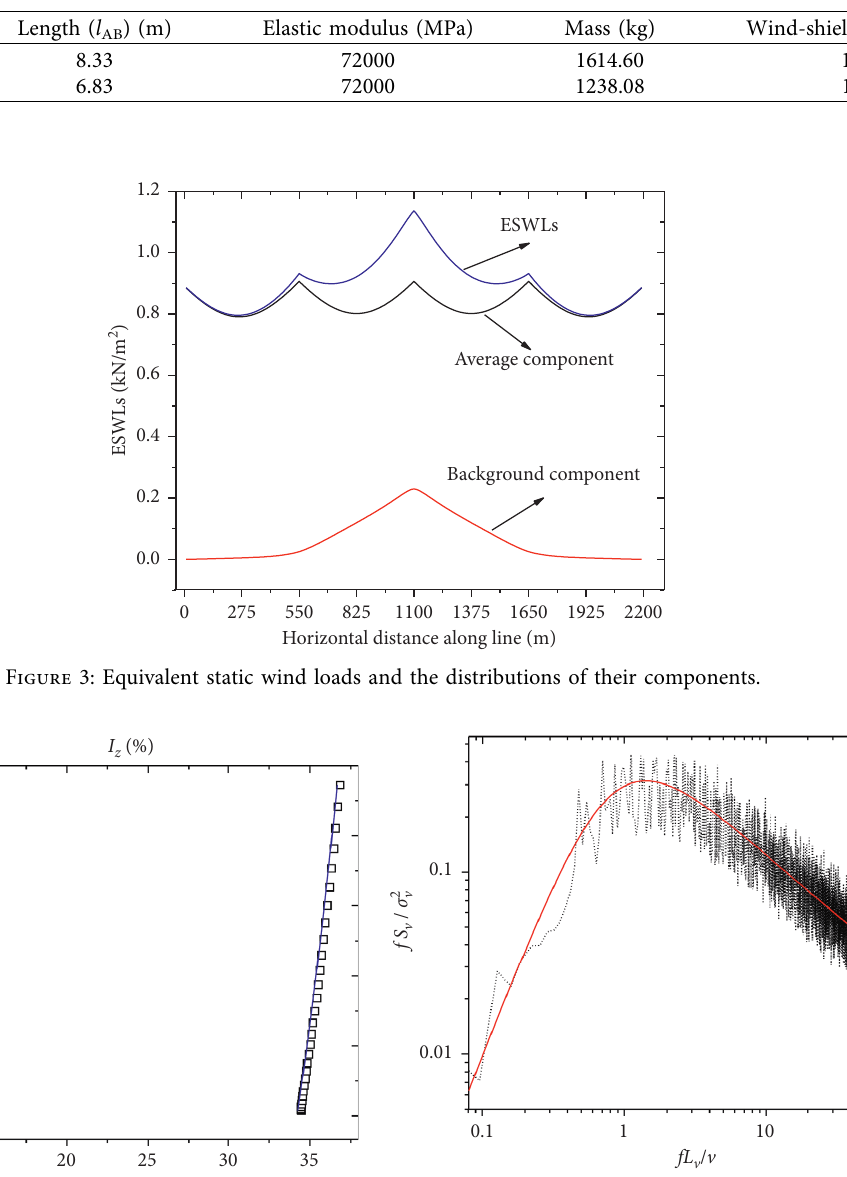
Table 2: Physical parameters of the insulator string.